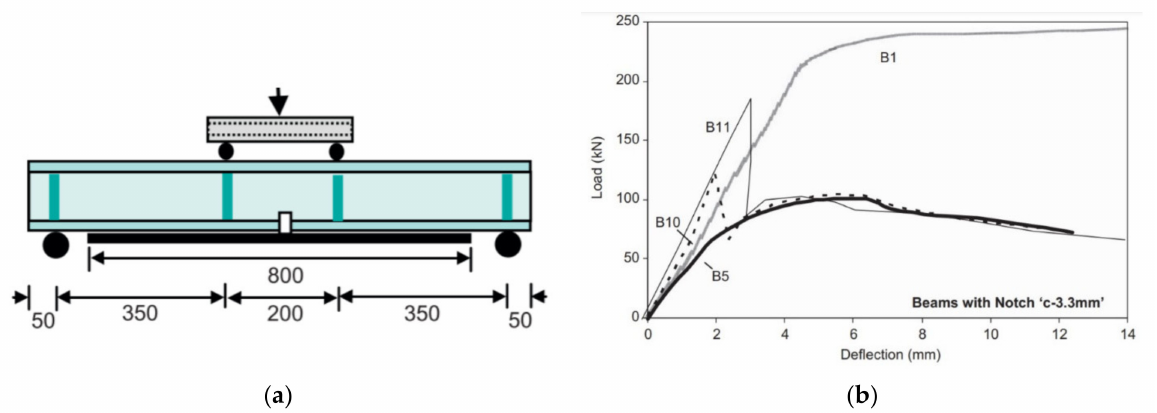
Figure 12. ( a ) Test set up of CFRP repaired notched composite beams. ( b ) Beams with full cut, Notches type “c” [138]; used with permission from Thin-Walled Structures, Elsevier,